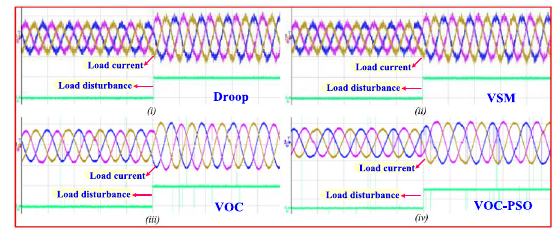
Fig. 25 Load current [Ch-1, 2, and 3 are phase currents, Ch-4 is load side disturbance]; (i) Droop control (ii) VSM (iii) VOC and (iv) VOC-PSO; [ Ch -1, 2, and 3: 10 A/div or and Ch -4: 1 V/div]